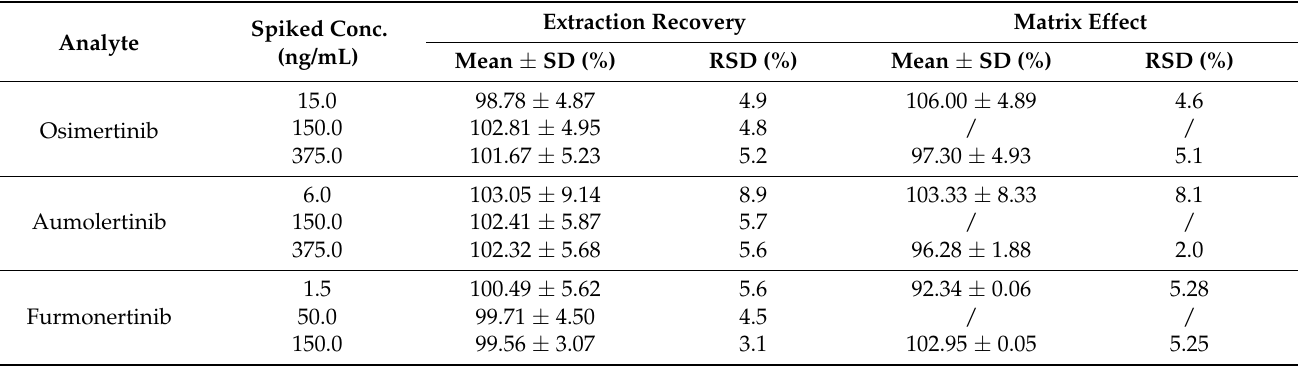
Table 2. Matrix effect and extraction recovery of analytes in human plasma (n = 6).